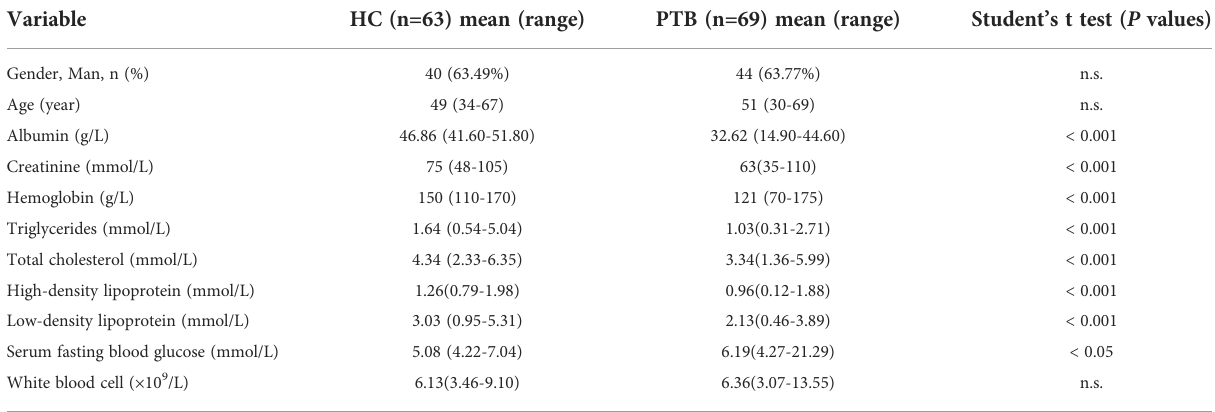
TABLE 1 Clinical characteristics of the